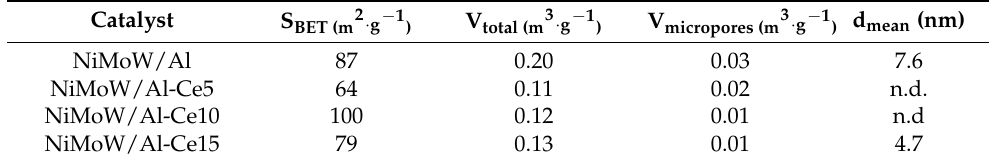
Table 3. Textural data of calcined catalysts calculated from the N 2 adsorption-desorption isotherms.